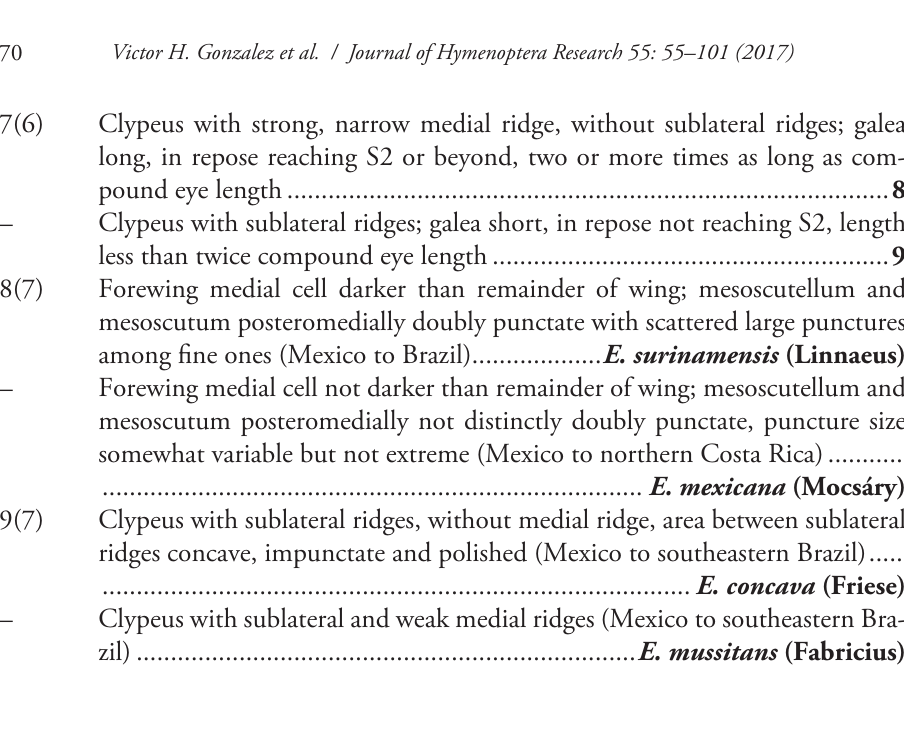
Genus Eufriesea Cockerell, 1908 Eufriesea coerulescens (Lepeletier de Saint Fargeau, 1841) Male, Figs 1, 7–9, 22, 34–45; Female, Figs 29, 31, 46–50 Euglossa coerulescens Lepeletier de Saint Fargeau, 1841: 11 (Lectotype: MNHN; ♂ , Mexico); Moure, 1967: 407 (lectotype designation) Diagnosis. The male of this species shares with that of E. oliveri and E. simillima the subapical projection of the anterior margin of the male metatibia, which is formed by the medial portion of the ridge that borders the depressed area and thus located above the inner spur, and the dorsal lobe of the gonostylus, which is apically about as broad as its base and largely bare on its outer surface. It can be separated from E. simillima by the length of the glossa (reaching mesotrochanter in E. coerulescens vs. reaching metatro- chanter in E. simillima ), presence of a longitudinal median depression on clypeus (ab- sent in E. simillima ), outer surface of mesotibia with area between the medial margin of the posterior felty patch and the anterior margin of tibia pubescent throughout except for small area apically (half bare apically in E. simillima ), and by the body color (largely metallic green in the male of E. coerulescens vs. dark blue with violet hues in both sexes of E. simillima ). In addition, both species are geographically separated: E. simillima is restricted to the western slope of the Cordillera of Chihuahua whereas E. coerulescens is more widely distributed, occurring along the Sierra Madre Oriental and eastern Mexico. From E. oliveri , which shares the same body coloration, it can be separated by the